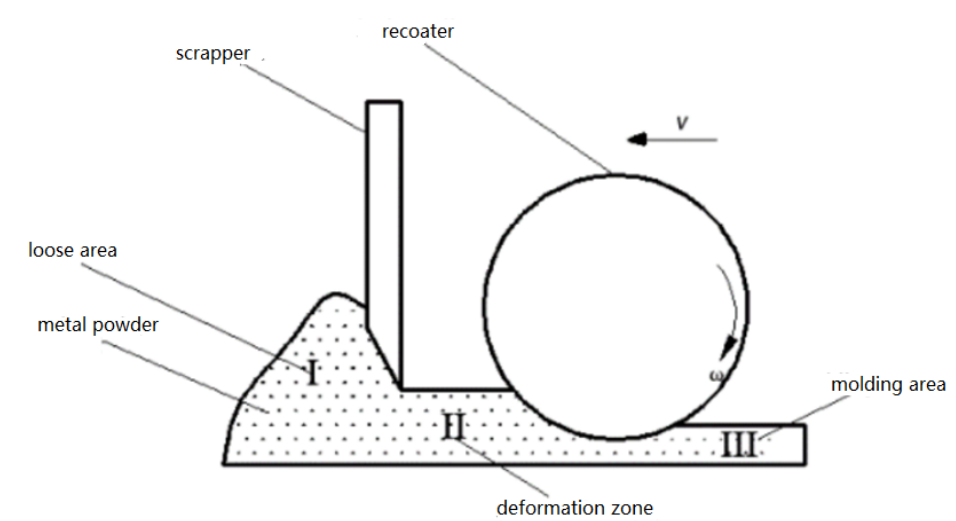
Figure 1. A motion model of the powder in contact with the recoater.